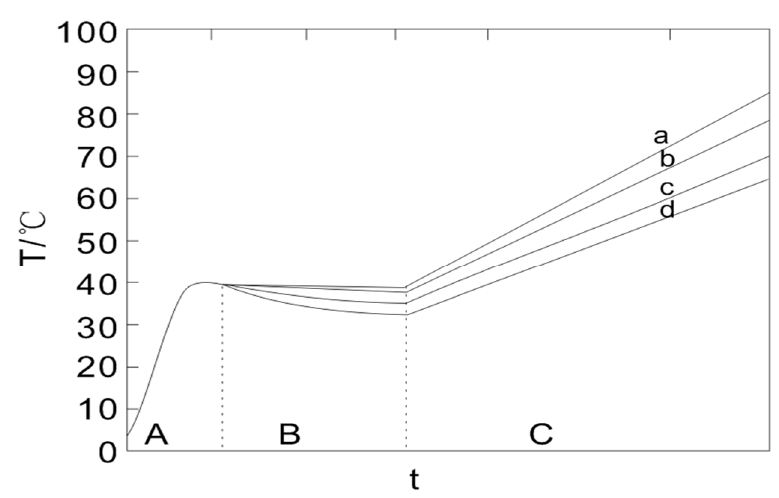
Figure 16. Variation of varistor temperature with impact time.